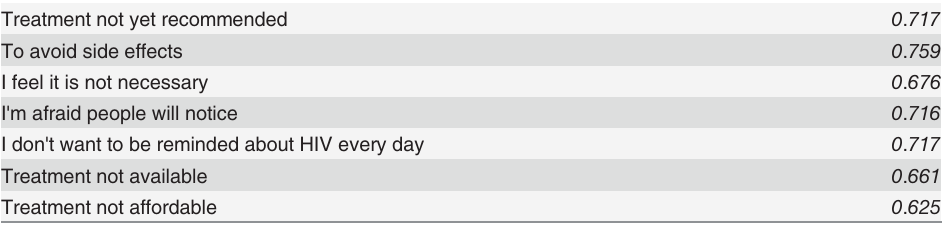
Table 3. Kaiser-Meyer-Olkin measures of sampling adequacy for the seven factors retained after prin- cipal component analysis. Treatment not yet recommended